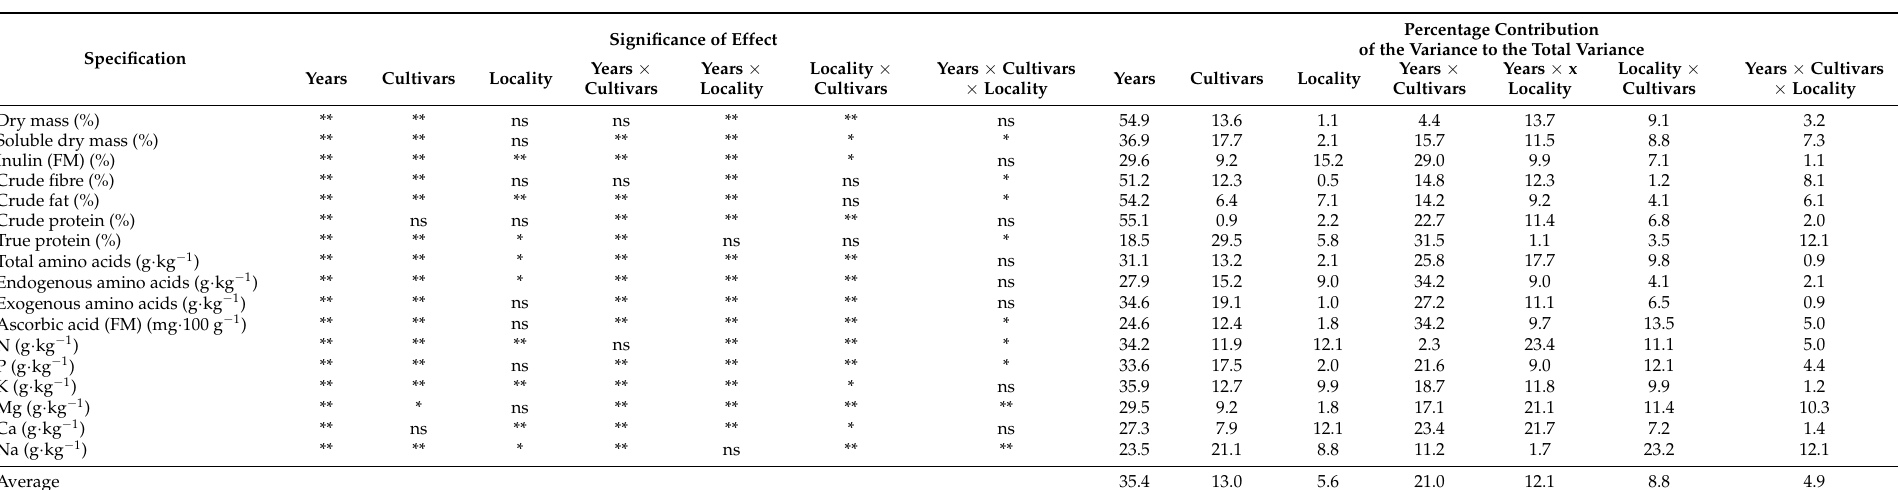
Table 7. Effect of cultivars, locality, and years on the chemical composition of H. tuberosus tubers and their percent contribution to the total